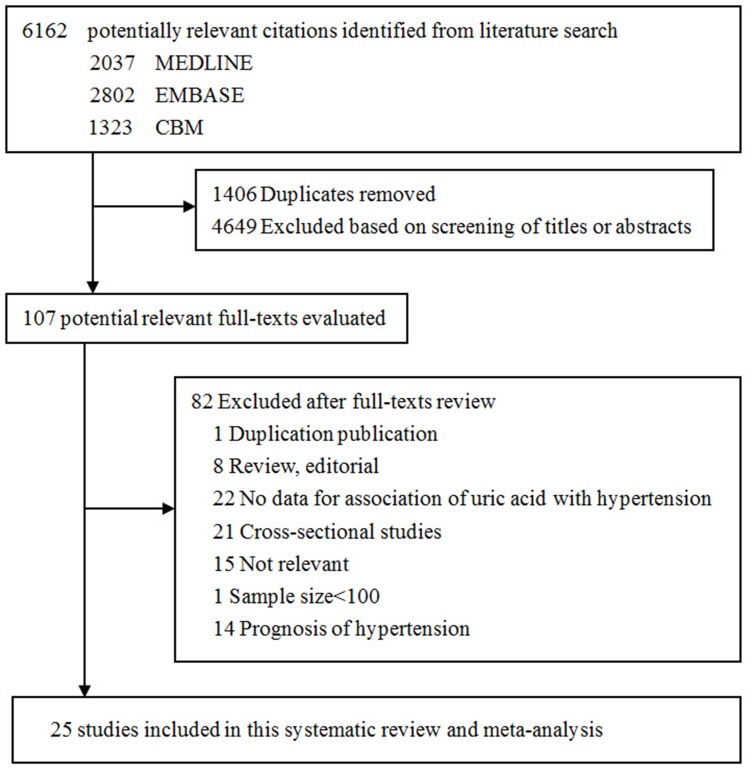
Flowchart of study selection.